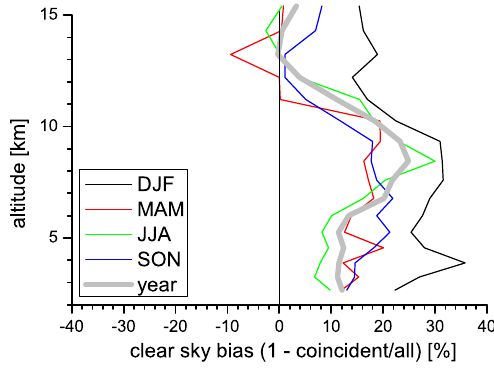
Fig. 12. Vertical profiles of the FTIR clear sky bias B, for winter (black line), spring (red line), summer (green line), autumn (blue line), and all seasons (thick grey